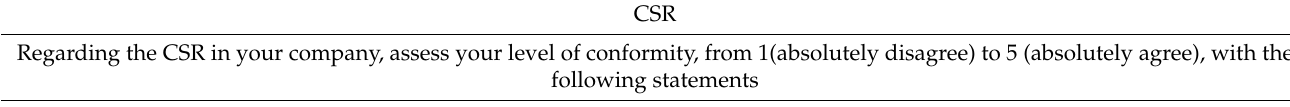
Table A1. Survey questions used in the